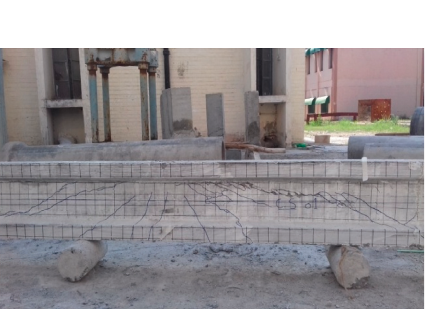
Figure 15: Crack patterns of